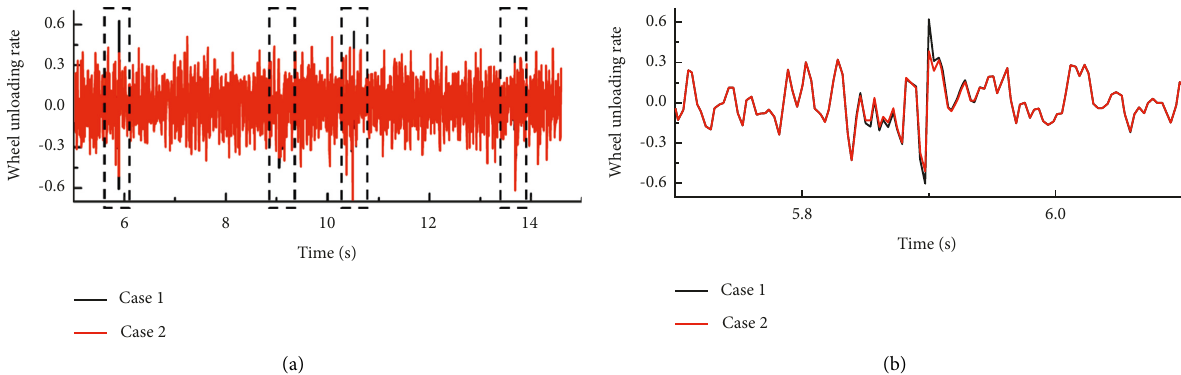
Figure 17: Time histories of the wheel unloading rate of the last wheelset in different cases: (a) the whole time period (b) the time period when the wheelset passes the first